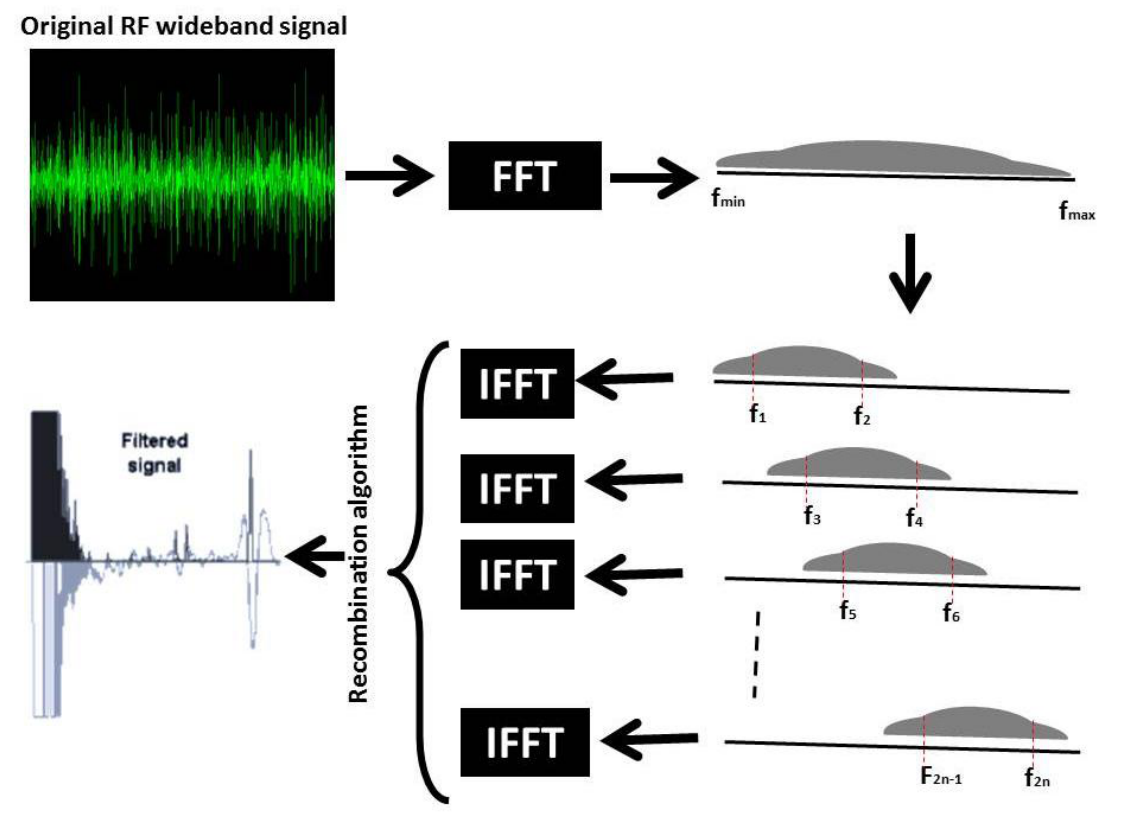
Figure 3. Flow diagram for